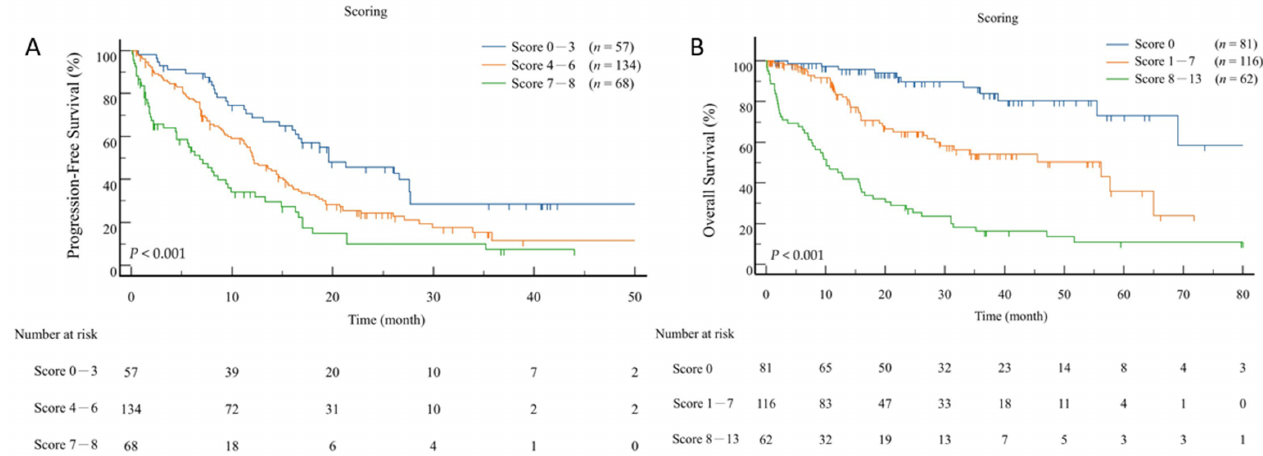
Figure 1. Kaplan–Meier estimates of progression-free survival ( A ) and overall survival ( B ) according to the prognostic scoring model.